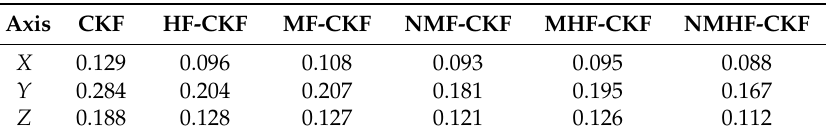
Table 3. Attitude RMSEs of each scheme (degree).